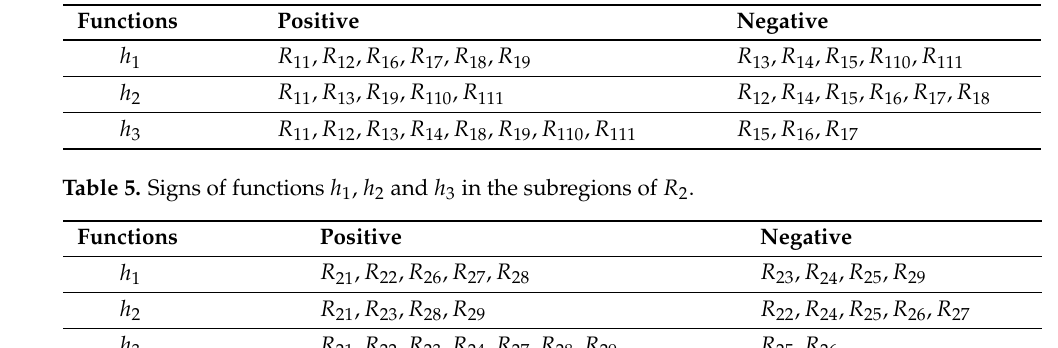
Table 4. Signs of functions h 1 , h 2 and h 3 in the subregions of R 1 .